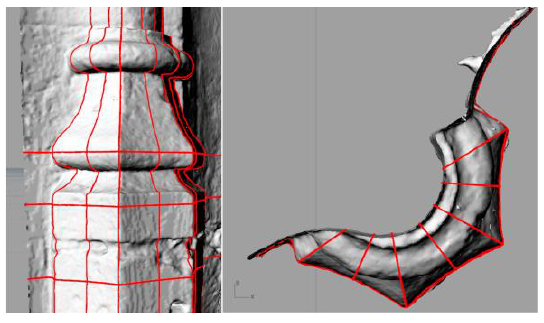
Figure 8. Elevation of the pillar (Cathedral of Seville) with sections